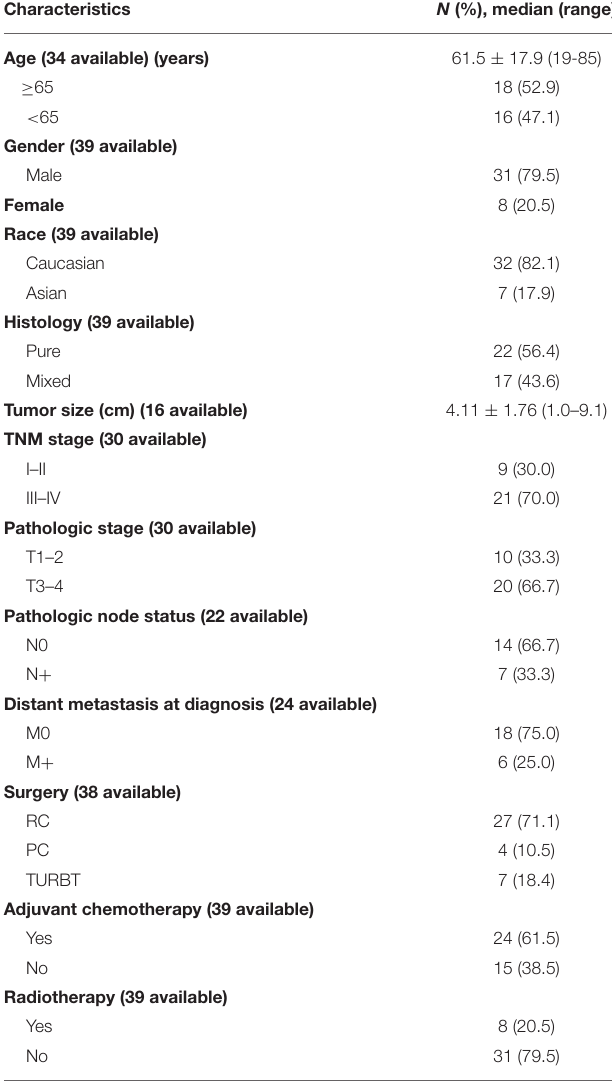
TABLE 1 | The baseline of clinicopathologic characteristics and therapy of